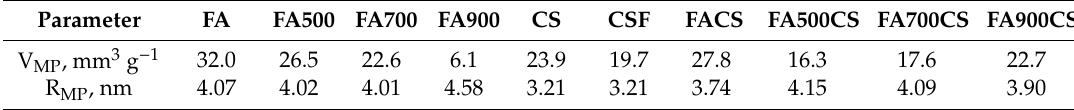
Table 3. Parameters of the finest ( ≤ 10 − 2 µ m) pores for the studied adsorbents. V MP volume of material pores, R MP average radius of material